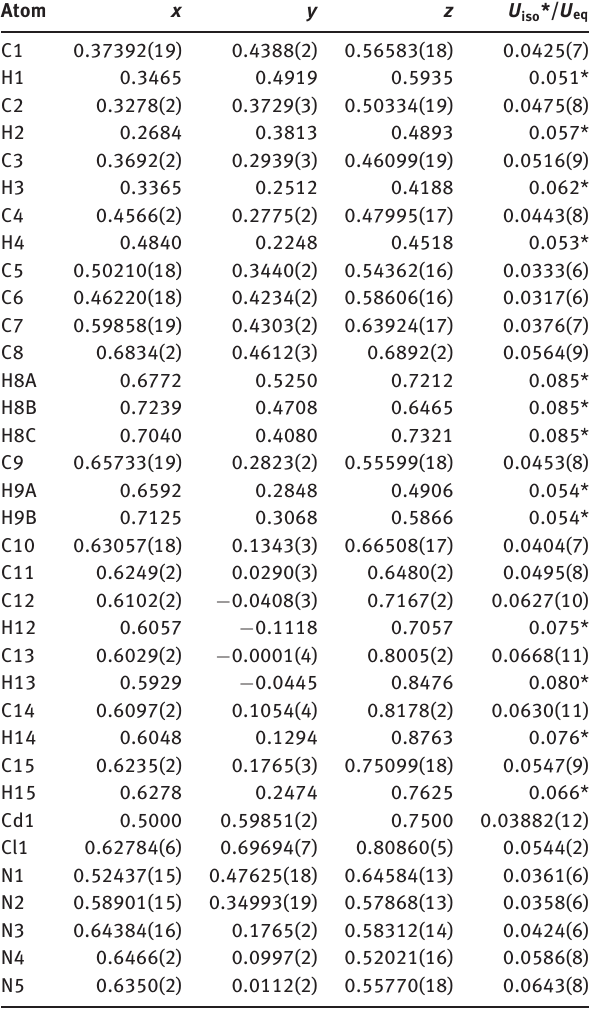
Table 2: Fractional atomic coordinates and isotropic or equivalent isotropic displacement parameters (Å 2